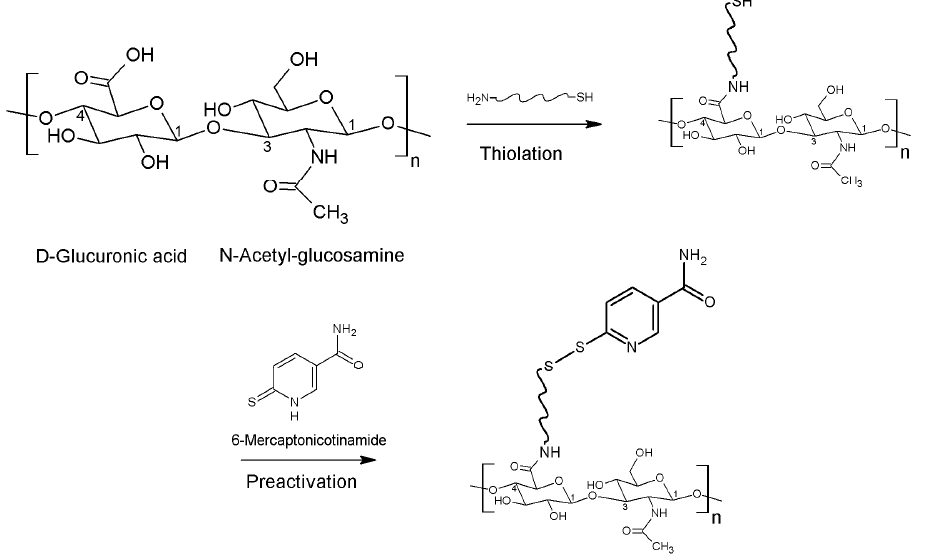
Figure 1. Chemical structure of disaccharide unit within the polysaccharide HA and schematic illustration of thiolation via amidation as well as preactivation with 6-mercaptonicotinamide as an example resulting in a disulfide bond.